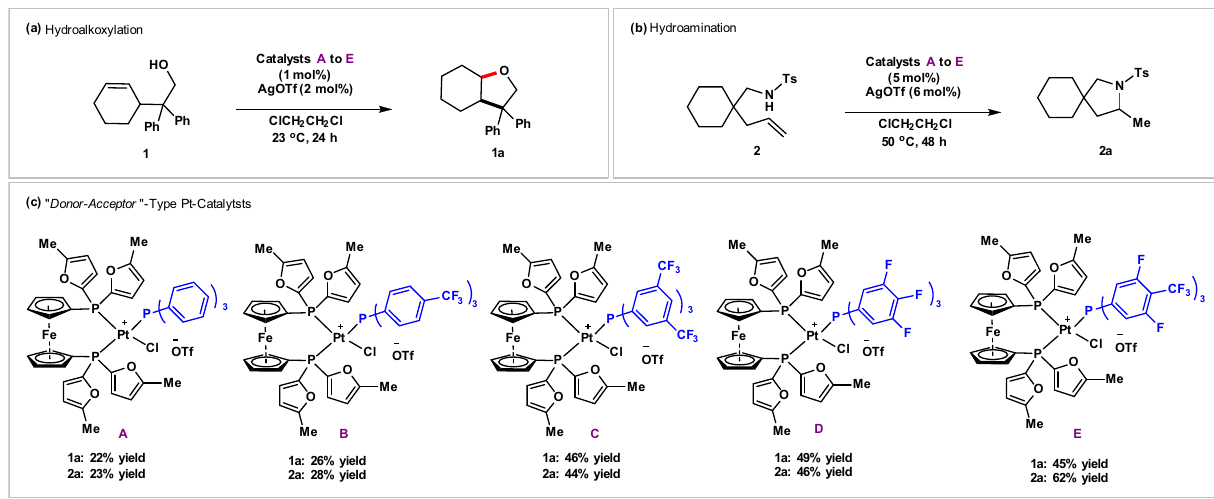
Fig. 2 Development of “ donor – acceptor ” type Pt catalysts for hydroalkoxylation and hydroamination. a Hydroalkoxylation. b Hydroamination. c Screening of “ donor – acceptor ” -type Pt catalysts for hydroalkoxylation and